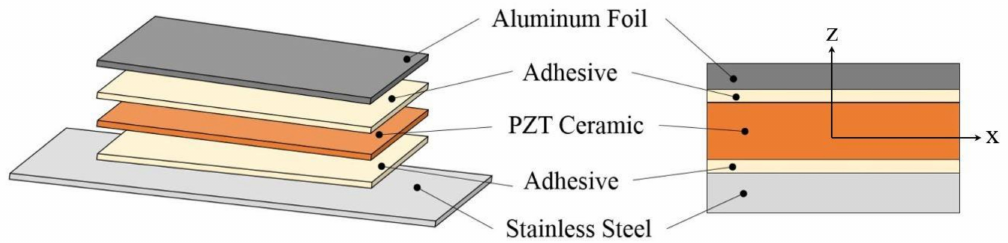
Figure 1. Layout of a laminated piezoelectric device.